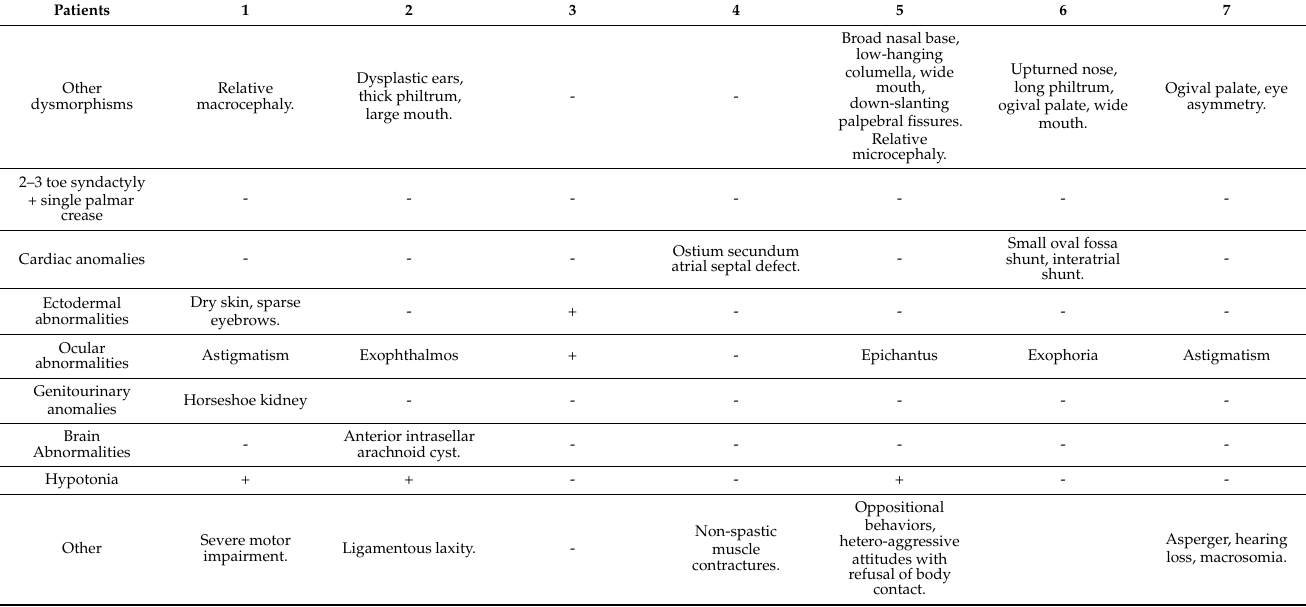
Table 1. Cont. Patients Broad nasal base, low-hanging Upturned nose, columella, wide mouth, long philtrum, Other Relative Ogival palate, eye - - down-slanting dysmorphisms macrocephaly. asymmetry. ogival palate, wide large mouth. palpebral fissures. mouth. Relative microcephaly. - - - - - Small oval fossa - Cardiac anomalies - - Ostium secundum atrial septal defect. - shunt, interatrial shunt. Dry skin, sparse Ectodermal abnormalities eyebrows. - - - - Ocular abnormalities Astigmatism - Epichantus Exophoria Astigmatism Genitourinary anomalies Horseshoe kidney - - - - - - Brain Anterior intrasellar Abnormalities - arachnoid cyst. - - - - - Hypotonia - Oppositional behaviors, Non-spastic hetero-aggressive Other Severe motor impairment. Ligamentouslaxity. - muscle attitudes with contractures. refusal of body